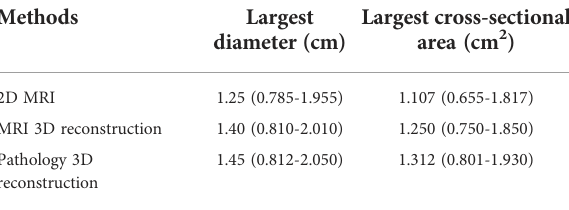
TABLE 6 Different examination methods to measure the largest diameter and cross-sectional area of residual tumor after NAT [M (95%CI)].